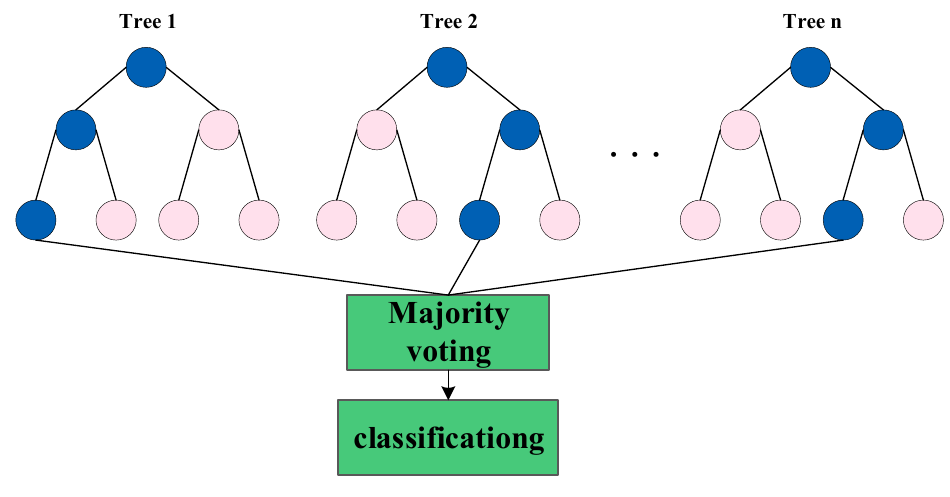
Figure 14. Structure of RF.